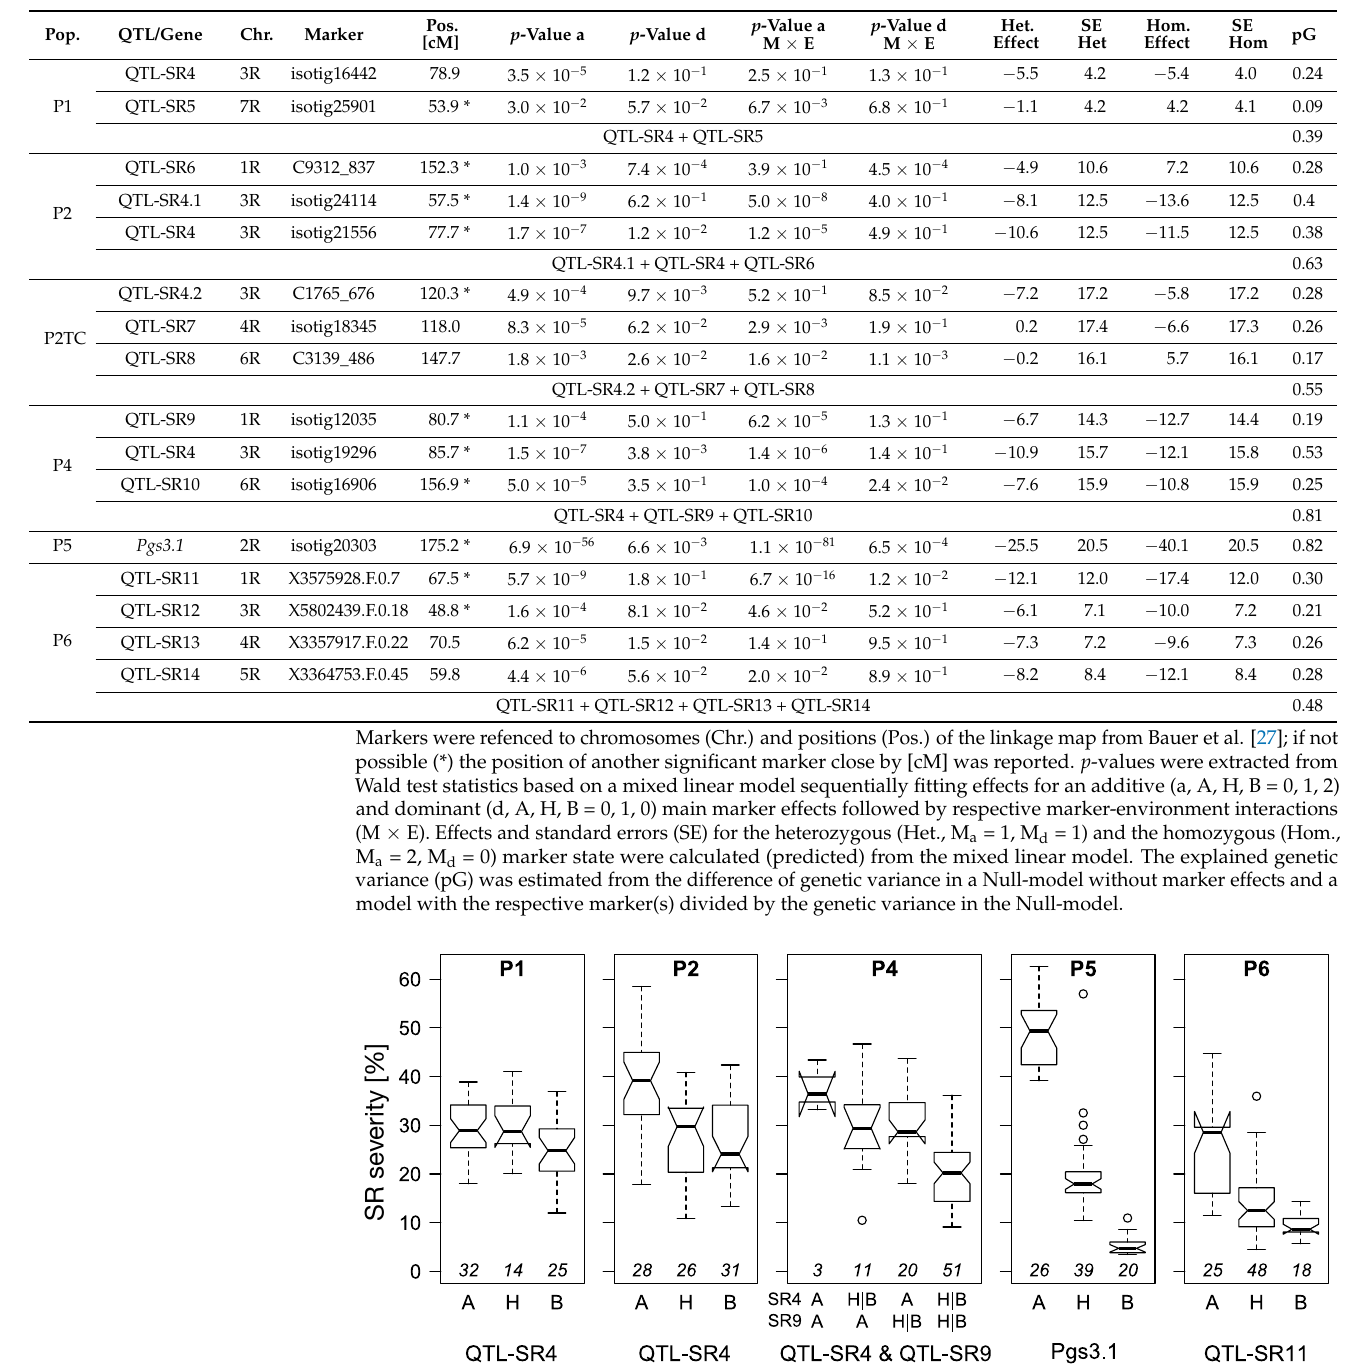
Table 4. QTL/Gene effects for stem rust that was artificially inoculated and assessed in the field and associated with respective markers in the different populations.